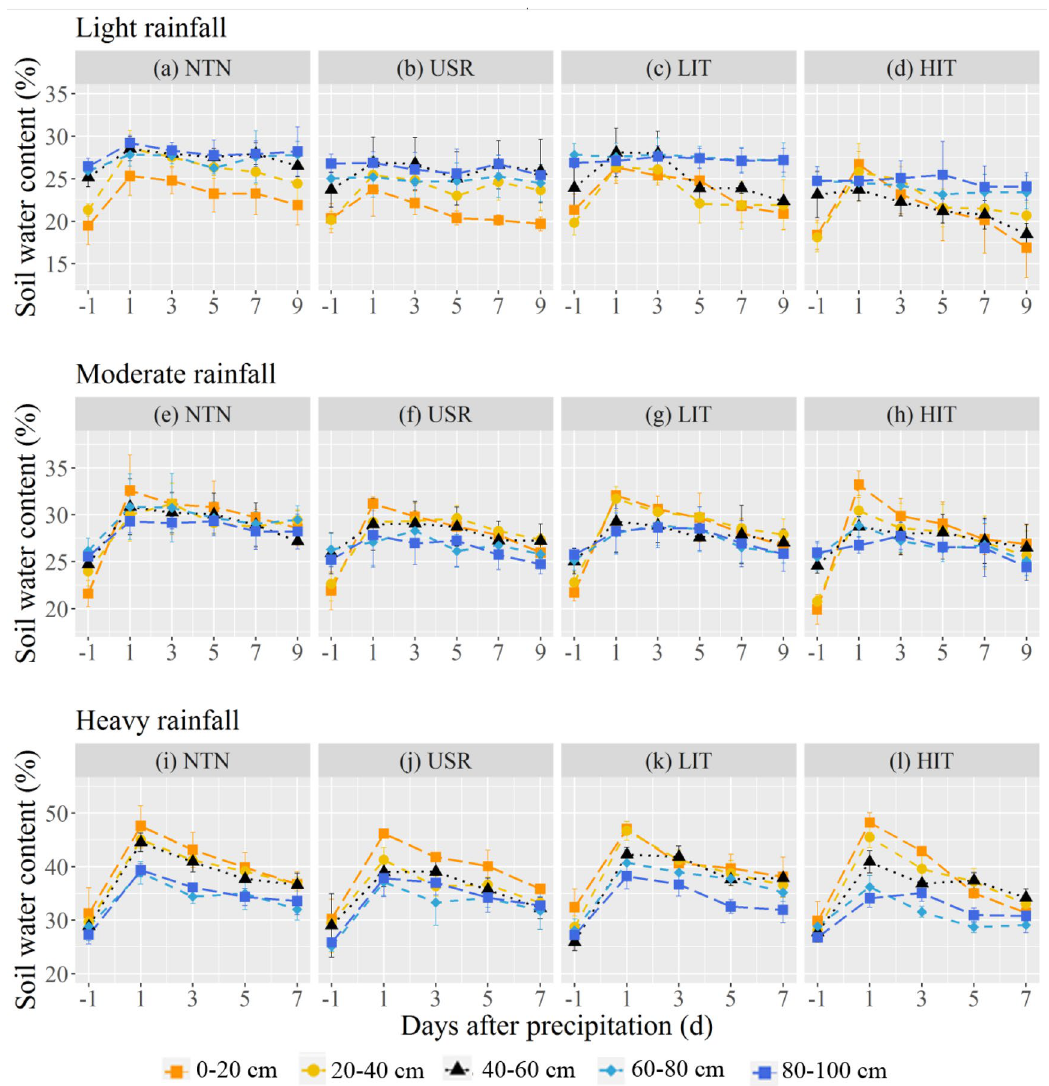
Figure 2. Daily soil water content (SWC) (mean ± SD, n = 3) of the P. massoniana stands with no thinning (NTN, a,e,i ), understory removal (USR, b,f,j ), light-intensity thinning (LIT, c,g,k ) and heavy-intensity thinning (HIT, d,h,l ) after the three rainfall